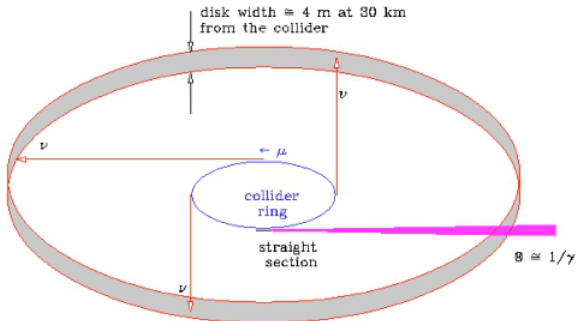
FIG. 62. (Color) Neutrino radiation disk. For a 3 TeV COM collider the neutrino radiation width is (cid:2) 4 cm at a distance of 30 km. A hot spot produced by a 0.1 m straight section in the ring contains roughly twice the number of neutrinos on the disk on average, depending on the details of the collider